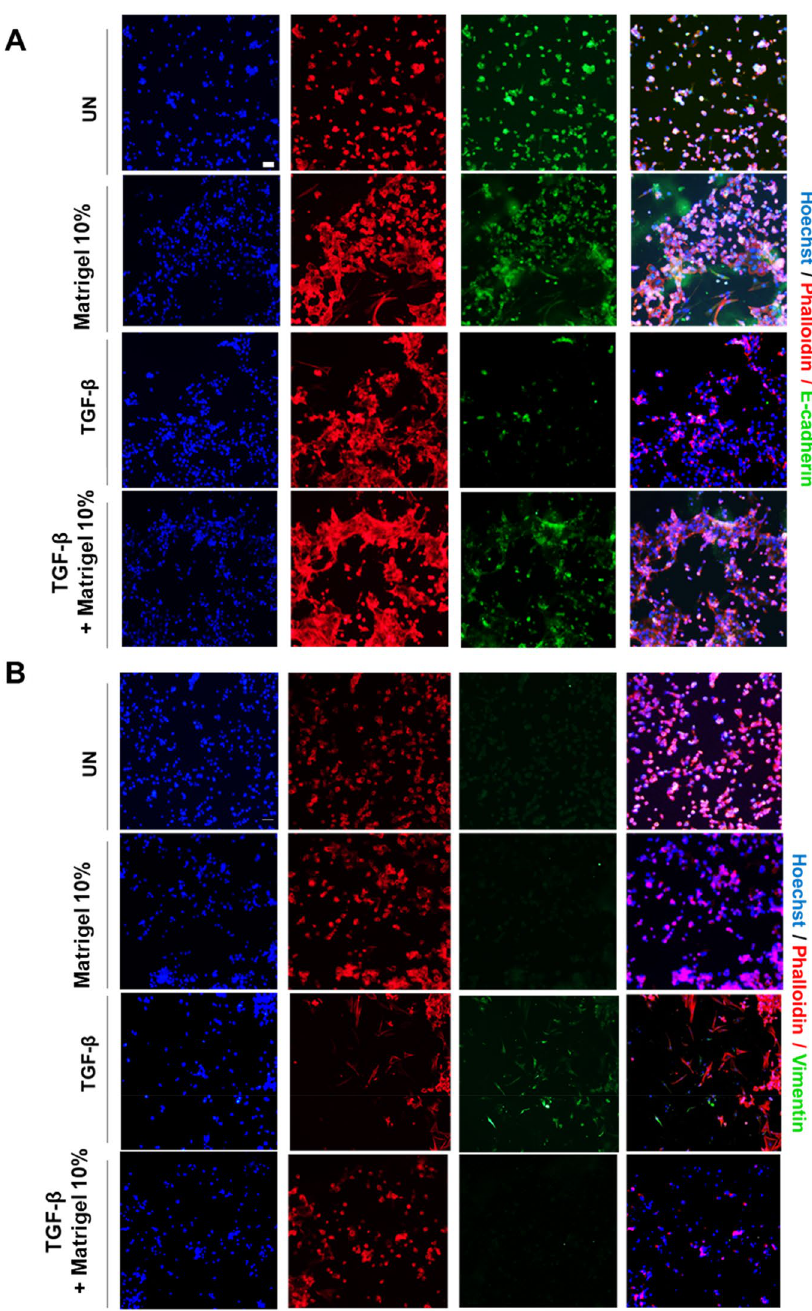
Figure 5. Representative confocal images of double phalloidin//E-cadherin ( A ) or phalloidin/Vimentin ( B ) immunofluorescence corresponding to 2D monolayer cultures treated with TGF-β, 10% Matrigel, 10% Matrigel plus TGF-β or left untreated (UN). Cells were counterstained with phalloidin to visualize actin cytoskeleton and morphology, and Hoechst to visualize nuclei. Scale bars: 25